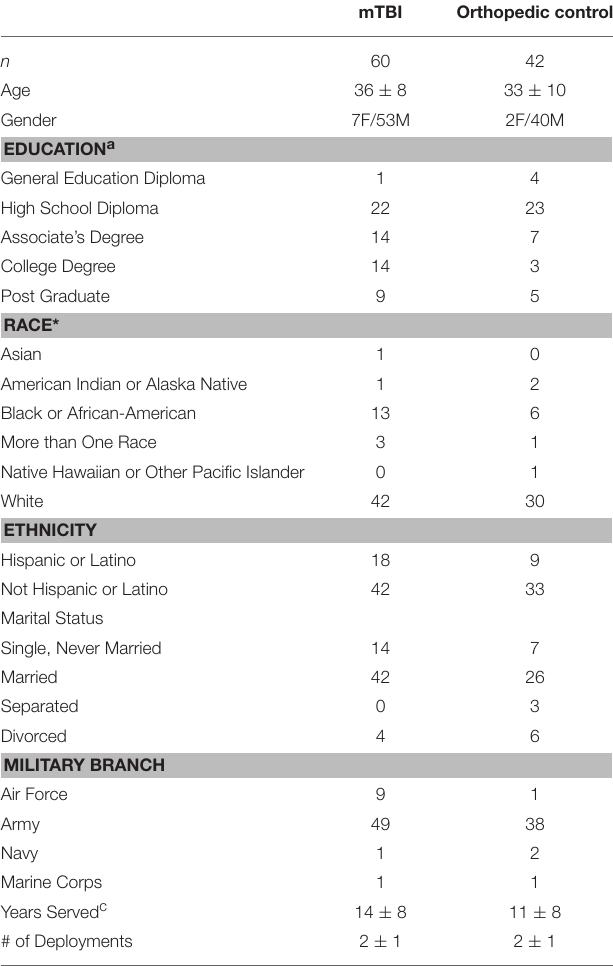
TABLE 1 | The mTBI and Control groups did not significantly differ for any variable except education level a [ χ 2 (4) = 9.5, p = 0.049], with the mTBI group having more post-high school